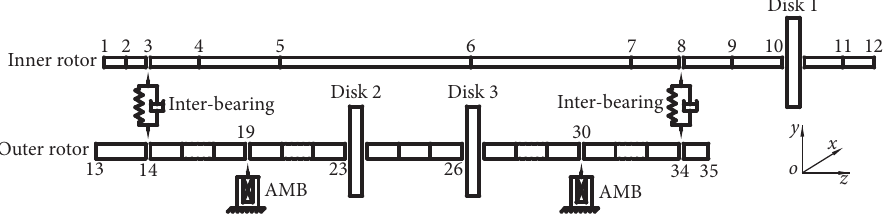
Figure 6: Finite element model of the